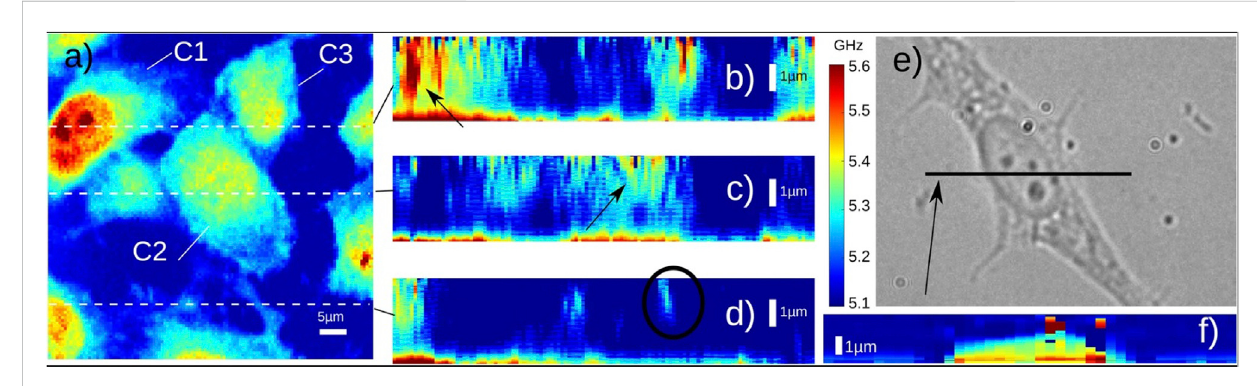
FIGURE 7 Brillouin imaging of fi xed 3T3 cells. (A) Three cells (C1 – C3) are shown in the image. (B – D) Depth images of three locations (indicated by the dashed lines in (A) Black circle indicates the location of fi lopodia. (E – F) Bright- fi eld image and Brillouin image of a 3T3 cell. Adapted from Ref. [69].